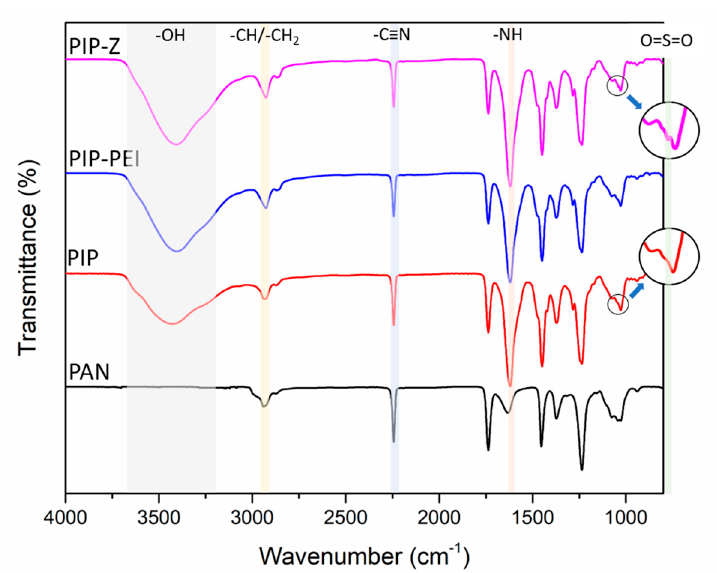
Table 1. Analysis of the TFC membranes.